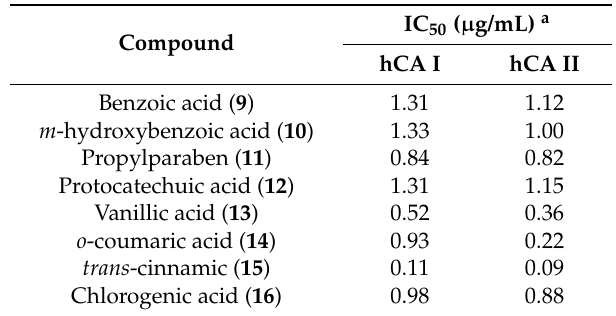
Table 1. Inhibition data of compounds 9 – 16 [45].